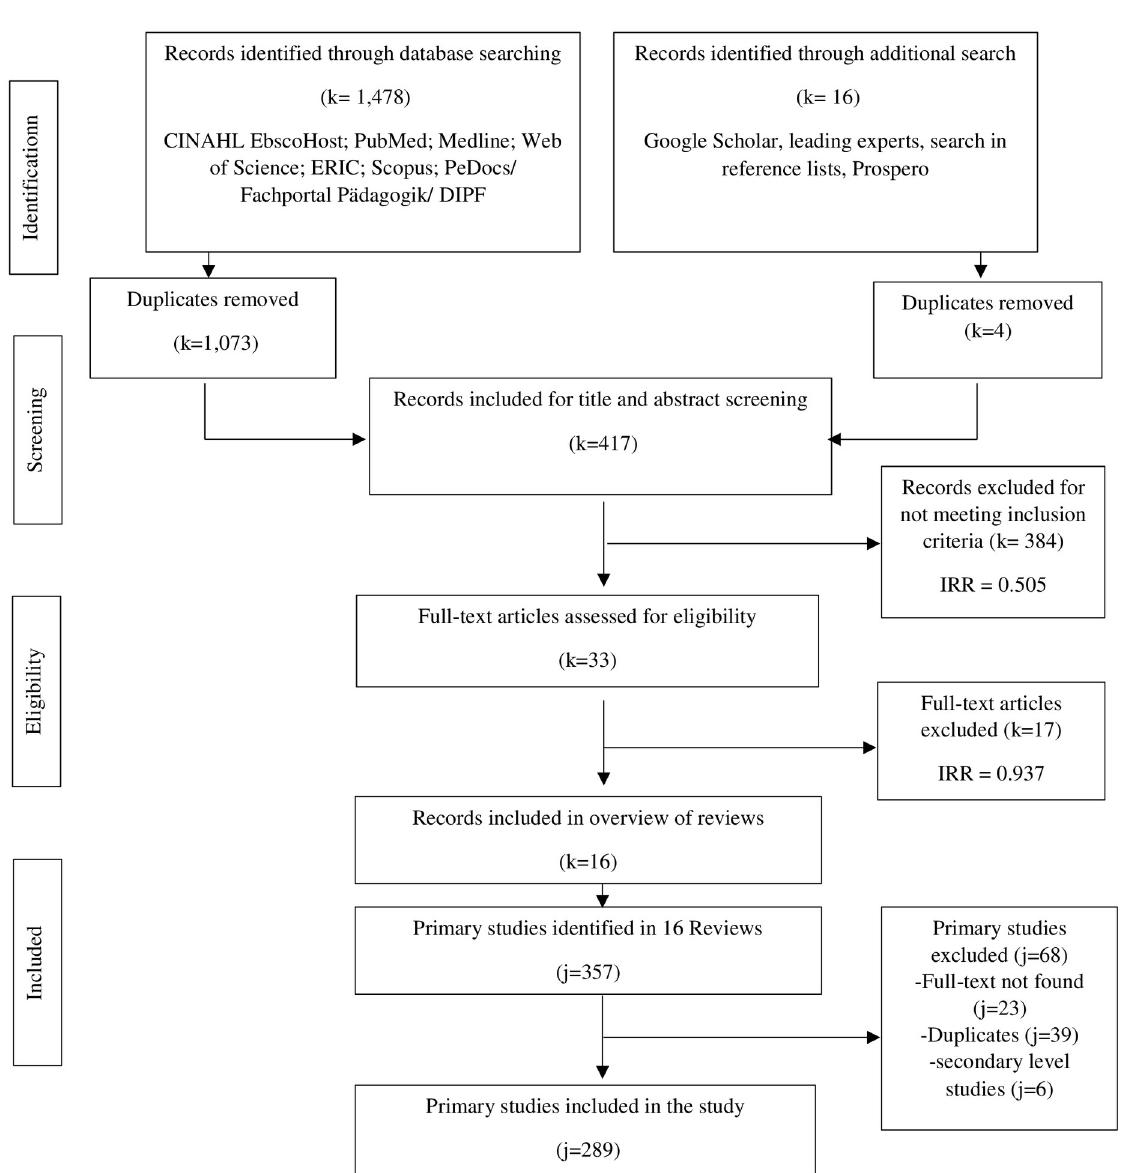
Fig 4. PRISMA flow chart [42] for reviews . Notes : k = reviews ; j = primary studies . A search f 9 databases identified 1,478 articles. The additional search yielded 16 more articles. After subtracting duplicates (k = l,077), abstract and title of 417 articles were screened. 33 articles met the inclusion criteria (k = 385 excluded). After full texts of the 33 articles were screened, 16 articles met the inclusion criteria (k = 17 excluded). Primary studies identified in 16 reviews were identified (j = 357). After subtracting duplicates (j = 39) and excluding reviews (j = 6), and a study that could not be found (j = l), 311 primary studies were identified, and full texts were searched for. Further 23 primary studies had to be excluded as full texts could not be found, which totaled in 289 included primary studies in this Overview of Reviews